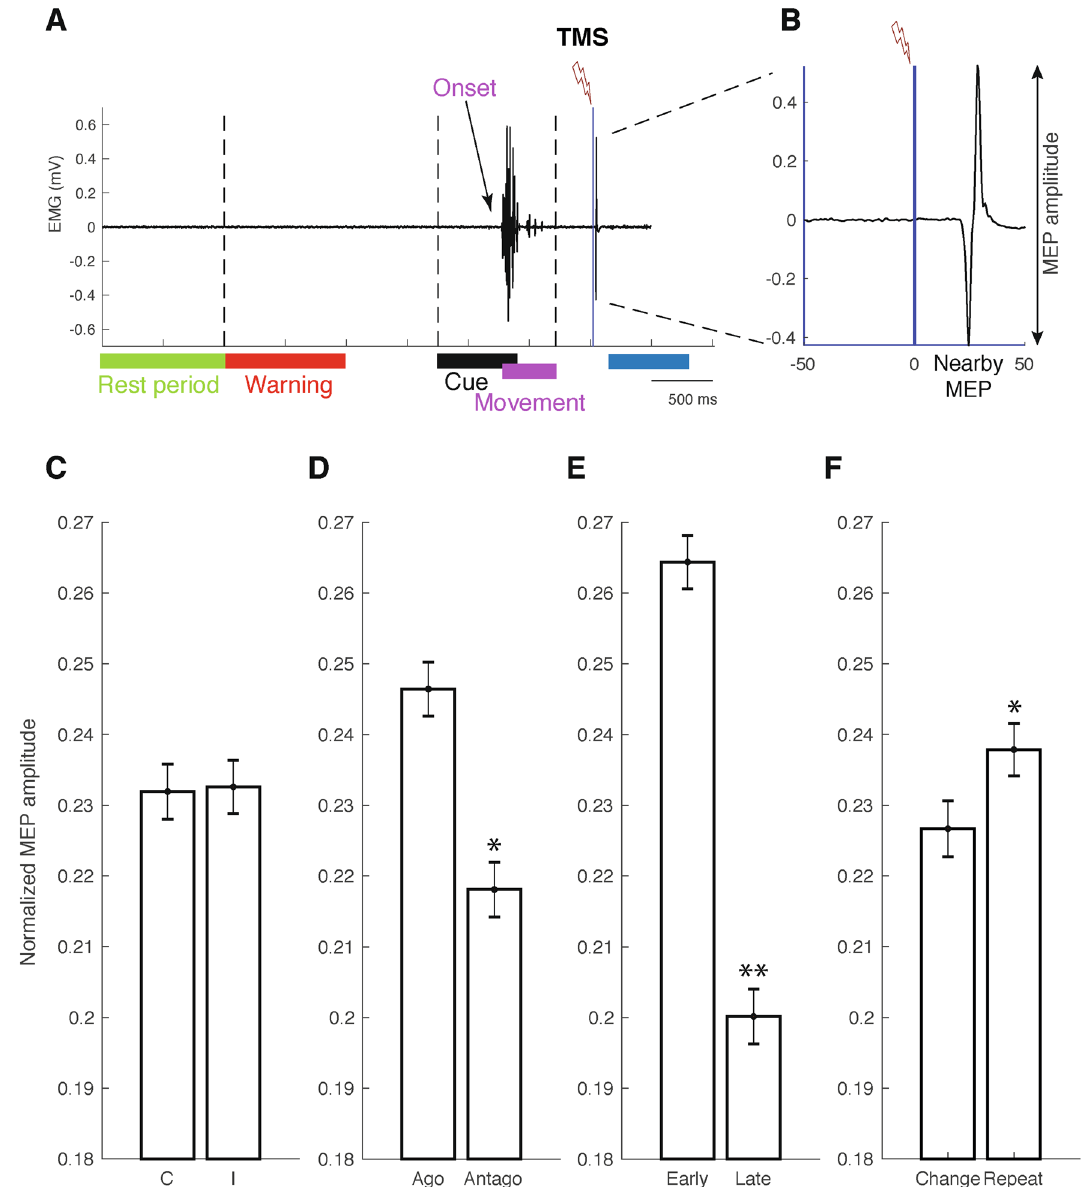
Figure 3. ( A ) Example of EMG activity recorded in a trial with agonist FDI movement and the MEP evoked by an early TMS after the voluntary muscle contraction. ( B ) Zoom of the MEP whose amplitude was used as a measure of corticospinal excitability. ( C – F ) Normalized MEP amplitudes as a function of the congruent or incongruent cognitive condition ( C ), agonist or antagonist movement direction ( D ), early or late TMS timing ( E ) and movement history (change or repetition) ( F ). Note the lack of altered post-movement CSE modulation as a function of cognitive condition in trial n ( C ), but an increase in CSE when an agonist movement had just been executed ( D ). This effect persisted after movement execution, ( E , left), but had declined significantly by the time of the late TMS ( E , right). CSE also increased after a succession of identical target/response associations ( F ), indicating that despite a diminishing CSE over time, a medium-term influence of movement history remained. **p < 0.01; *p < tudes due to background noise in the EMG recordings, trials in which muscular pre-activation was greater than 100 μV within the 500 ms window immediately preceding the TMS pulse were discarded. TMS testing. A figure-of-eight coil (Double 70 mm Coil, Magstim Company Ltd, Whitland, Dyfed, UK) was used to stimulate the M1 over the left hemisphere. The coil was connected to a Magstim stimulator (Mag- stim Super Rapid 2 , maximum output 1.2 T at the surface of the coil, Magstim Co. Ltd. Whitland, Dyfed, UK) and was held tangentially on the left hemiscalp with its handle pointing backwards at an angle of about 45° from the midsagittal axis. The motor hotspot was defined as the optimal (minimum TMS intensity) scalp posi-